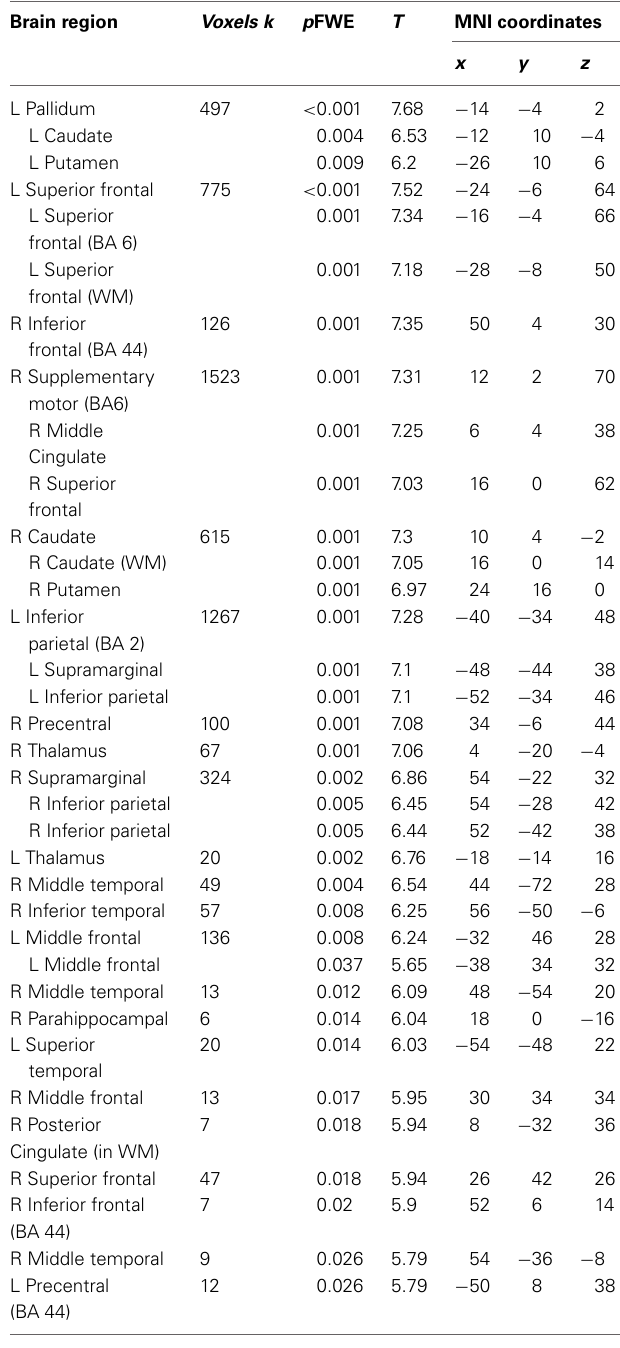
Cluster size k = number of contiguous voxels for that cluster. Contiguous sub- clusters shown beneath parent cluster. P-values peak-corrected for multiple comparisons, pFWE <